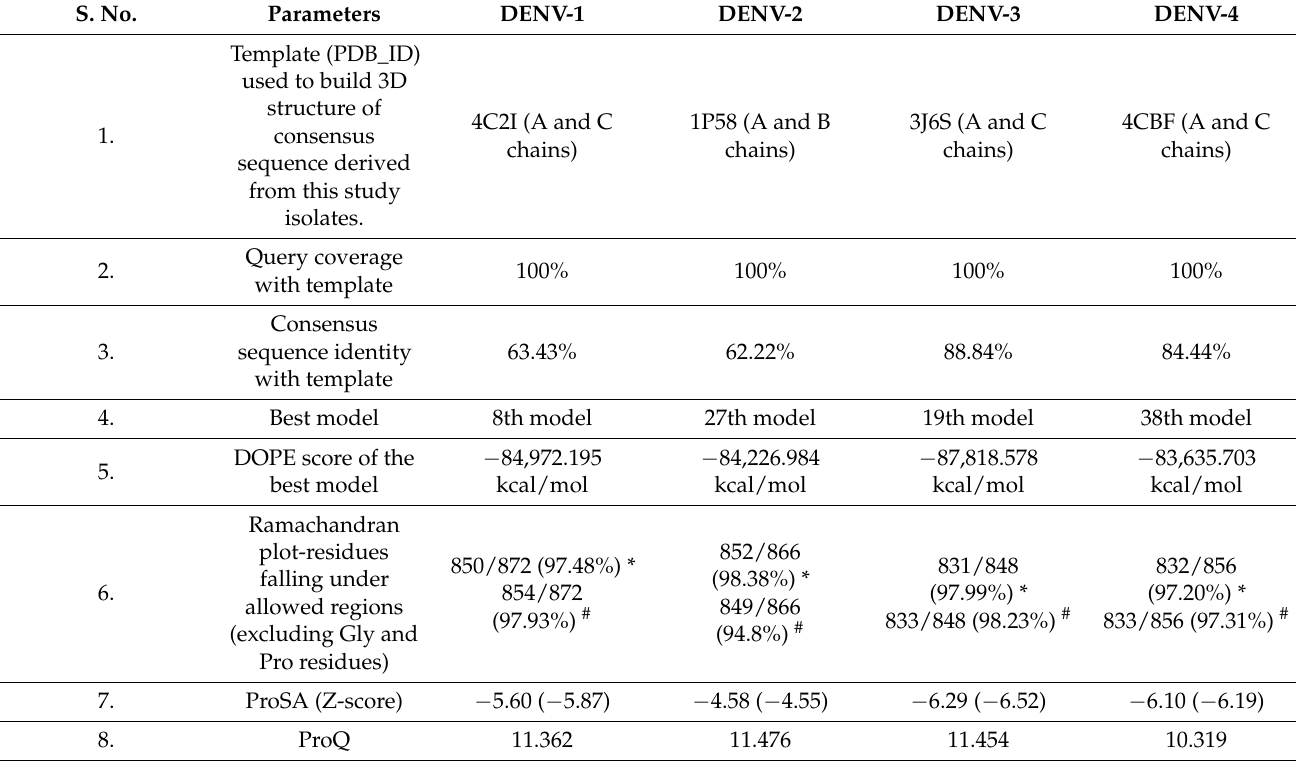
Table 5. Parameters used to build 3D structure of envelop protein from consensus